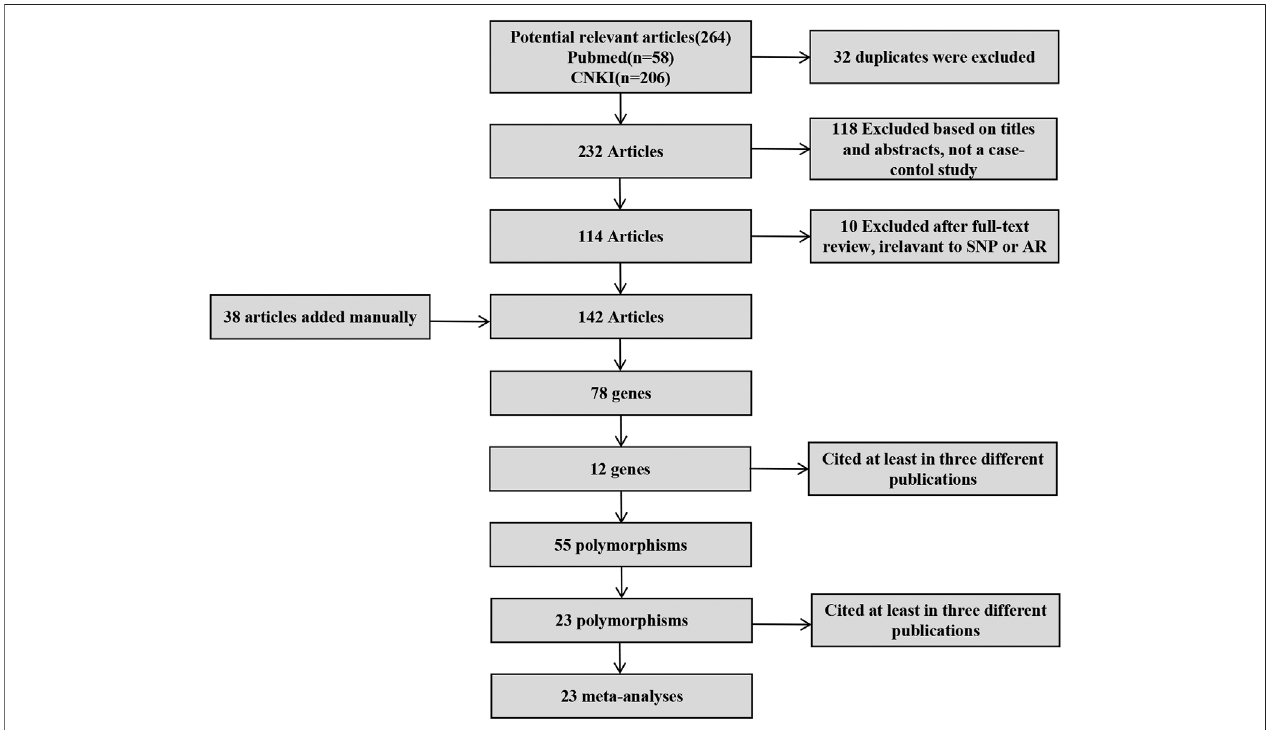
FIGURE 1 | Screening of polymorphisms for